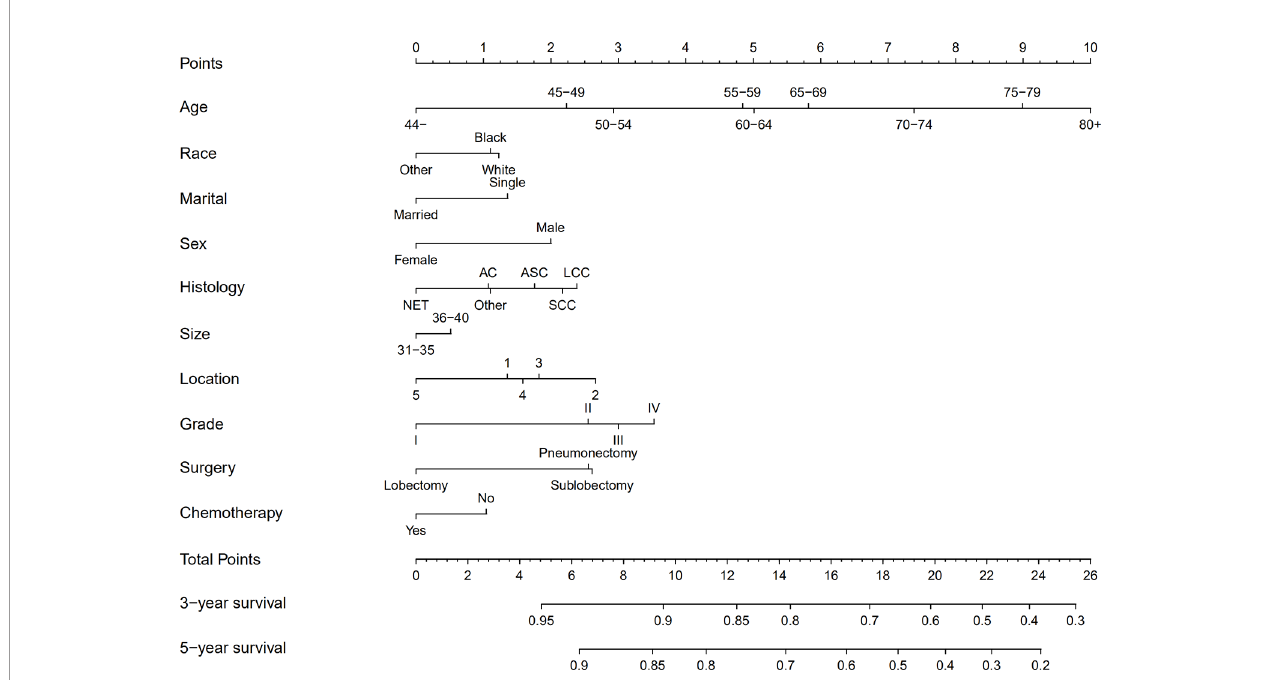
FIGURE 4 | Nomograms for predicting the 3- and 5-year OS rates of patients with stage IB NSCLC undergoing surgery. AC, Adenocarcinoma; SCC, Squamous cell carcinoma; LCC, Large cell carcinoma; ASC, Adenosquamous carcinoma; NET, Neuroendocrine tumor; LNs, Lymph nodes; OS, Overall survival; Grade I, Well differentiation; Grade II, Moderate differentiation; Grade III, Poor differentiation; Grade IV,